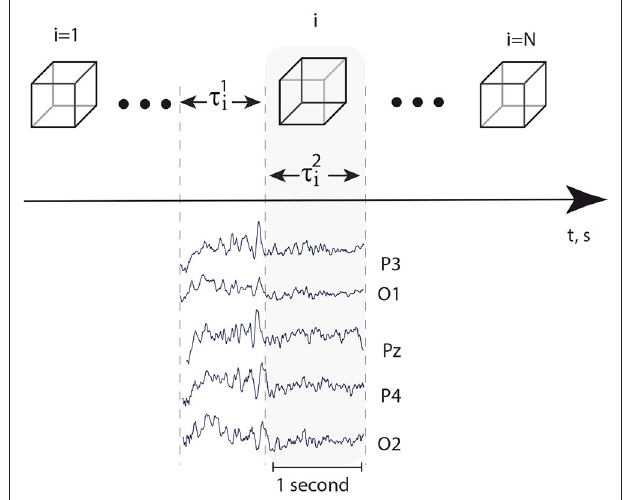
FIGURE 2 | Top: successively presented visual stimuli and time intervals τ 1 i = 1 s and τ 2 i = 1 s, preceded stimuli presentation and followed immediately by the moment of stimulus presentation, respectively. Bottom: typical EEG traces registered in occipital area during time intervals τ 1 i and τ 2 i